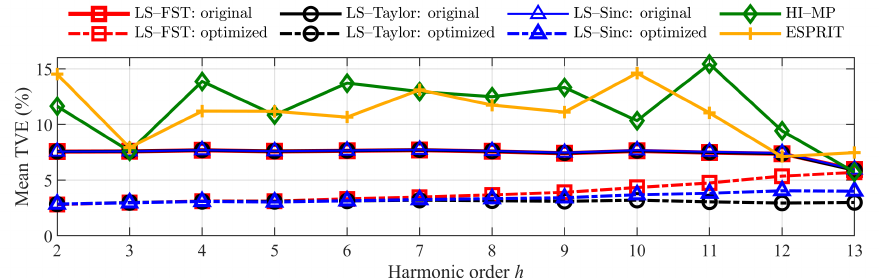
Figure 11. The mean TVE of LS-FST, LS-Taylor, and LS-Sinc with and without the proposed optimiza- tion, as well as the HI-MP and ESPRIT methods under harmonic phase modulation test.